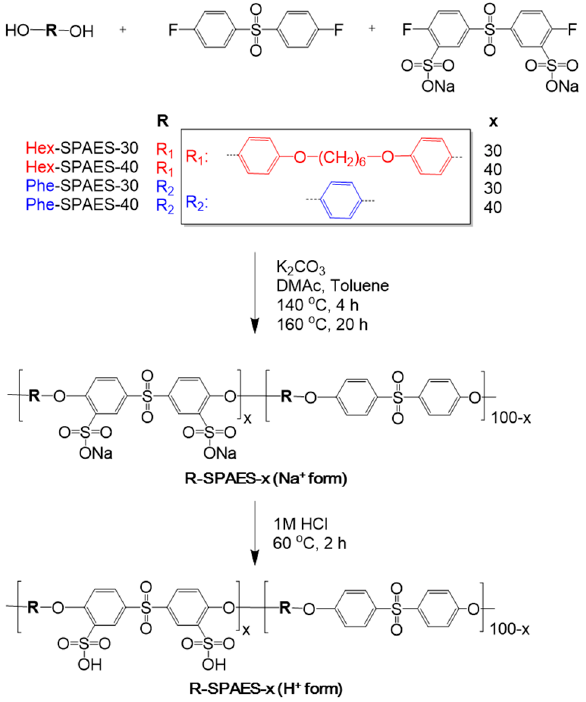
Scheme 1. Synthetic route to Hex-SPAES-x bearing hexyl aliphatic chains and Phe-SPAES-x con- taining no aliphatic chains (“Hex” and “Phe” refer to the “hexyl” and “phenyl”, respectively; “x” represents the percentage of repeating units containing sulfonic acid).